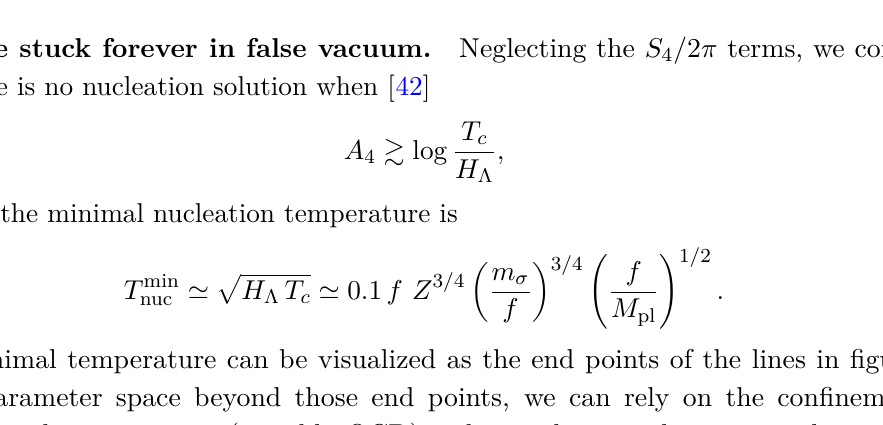
Figure 10 . We compare the temperature of nucleation via O (3) -symmetric bounce to the tempera- ture of nucleation via O (4) -symmetric bounce, computed numerically with an overshoot-undershoot method. We can see that the O (4) bounce dominates over the O (3) bounce for large supercooling f/T nuc , Z = 1 and N ≥ 3